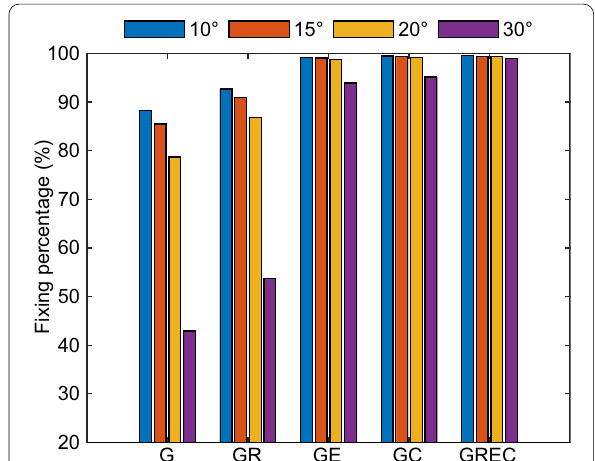
Fig. 4 Fixing percentage of PPP-RTK in different combination modes with different cut-off elevation angles from 10° to 30° at station at HKSC in Hong Kong, China (Li et al.,